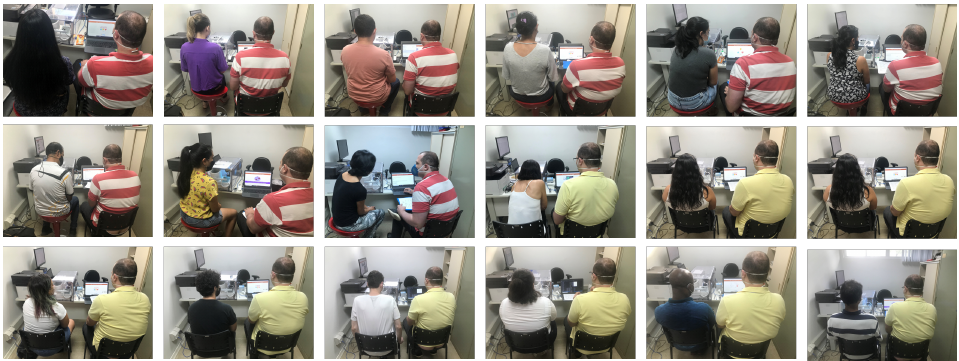
Figure A2. Brazilian volunteers taking the tests with the IPMA.